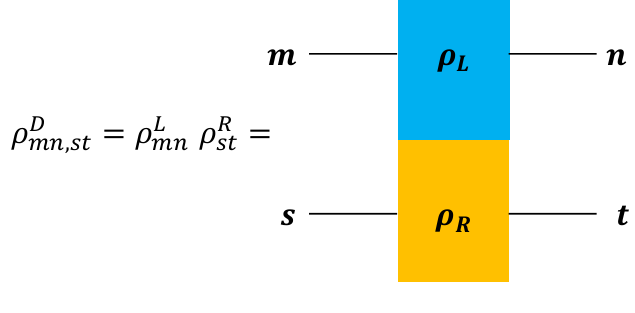
Figure 4: The schematic diagram of the definition of ρ D